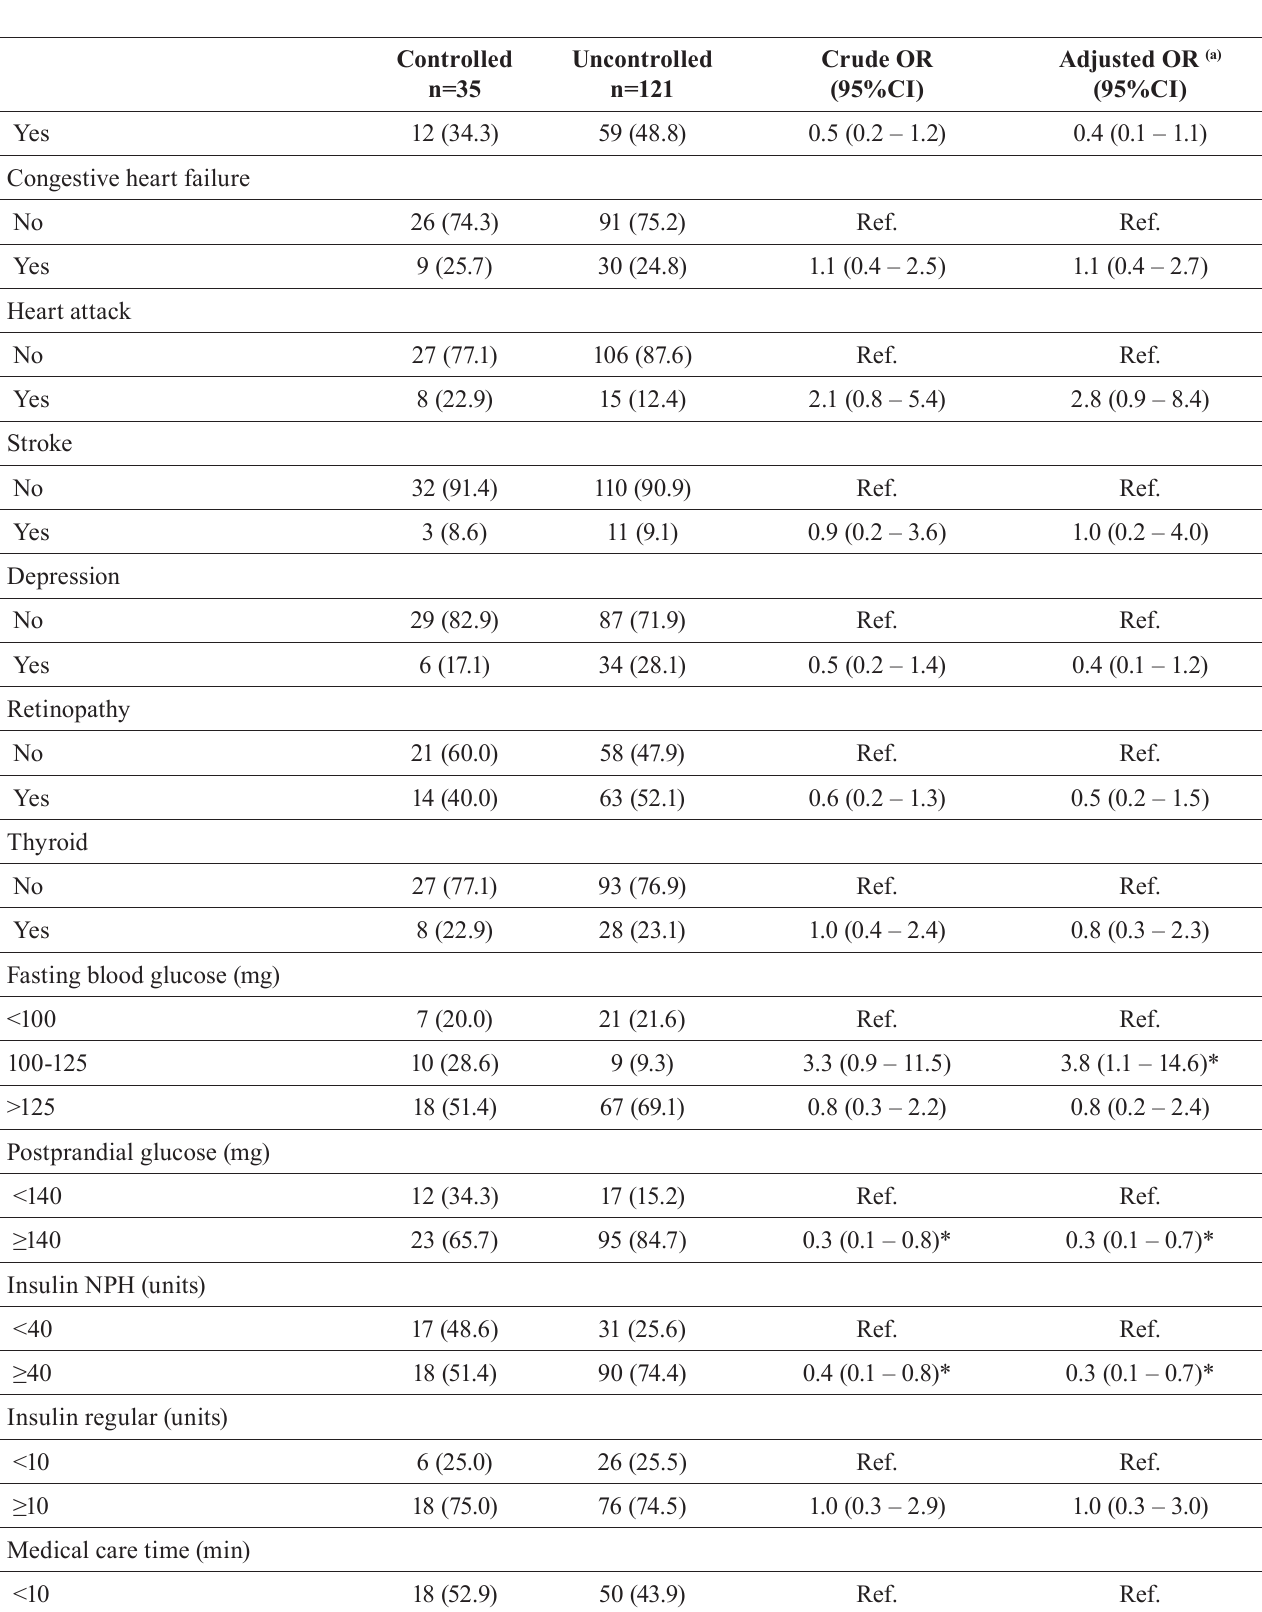
TABLE II - Logistic regression of the HB1Ac variable with the comorbidities